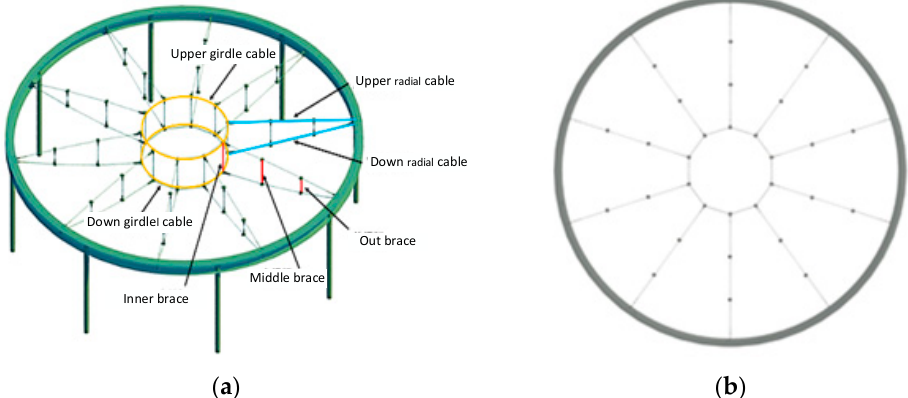
Figure 4. The model of the structure. ( a ) 3D model of the structure; ( b )Plane graphs of the struc- ture.